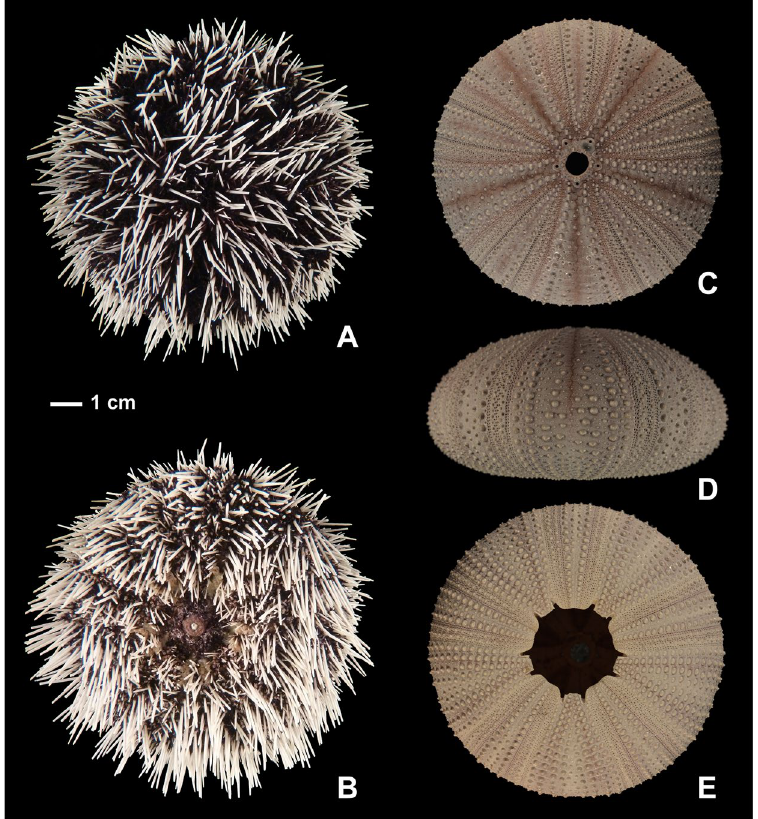
Figure 3. External appearance ( A , B ) and corona ( C – E ) of Tripneustes kermadecensis n. sp. Aboral ( A , C ), oral ( B , E ), and lateral views ( D ) of the holotype (AIM MA73563). Images ( A and B ) were taken from specimens submerged in water for better representation of soft tissue organs and true